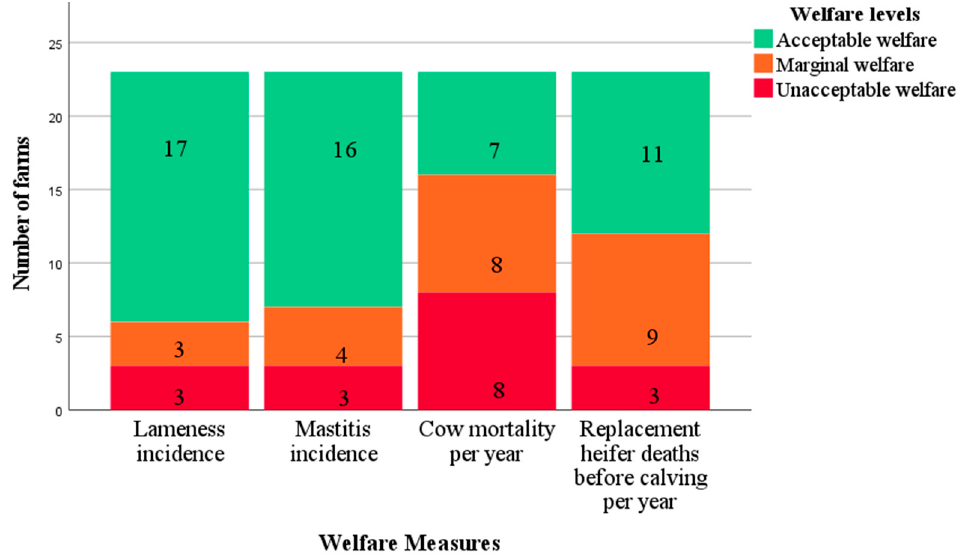
Figure 3. Stacked bar chart for welfare levels of disease and mortality data for 23 pasture-based dairy farms.